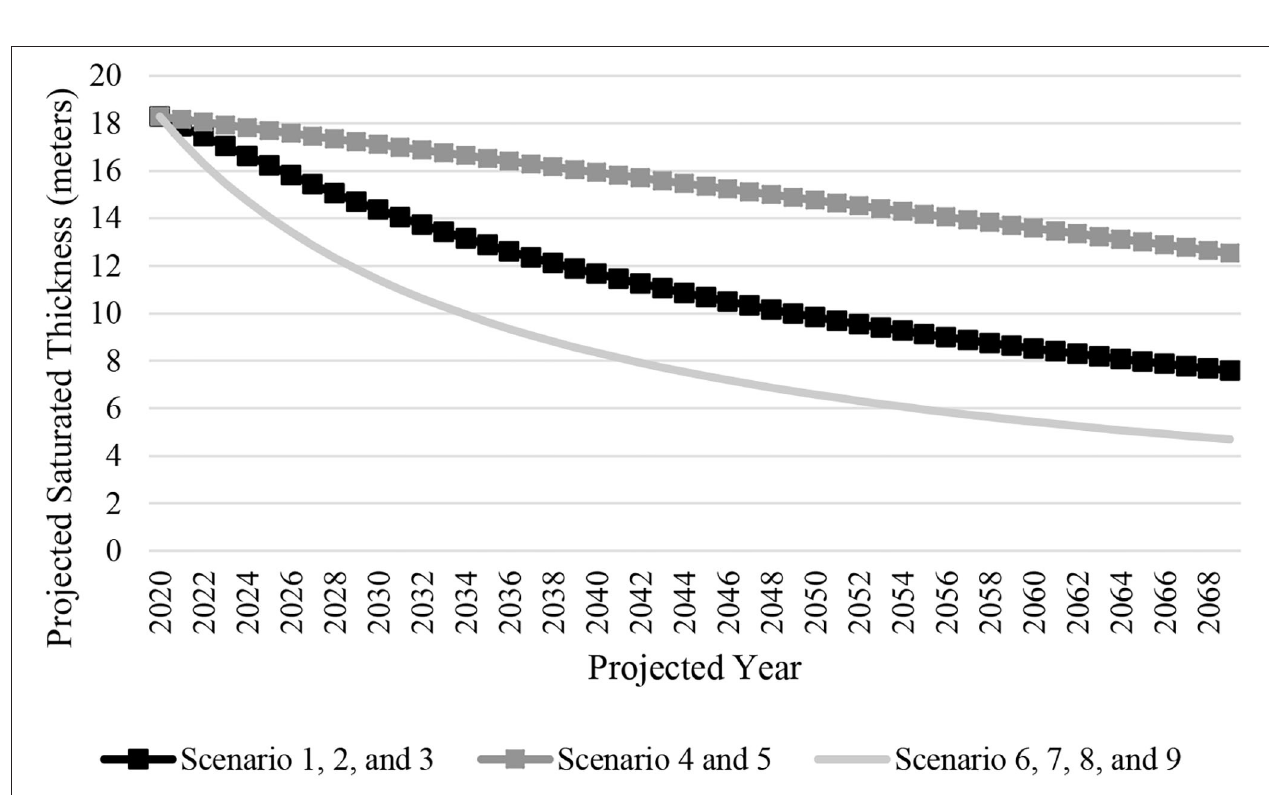
FIGURE 4 | Projected saturated thickness (m) across nine field-level scenarios for a representative farm in Hale County, Texas.